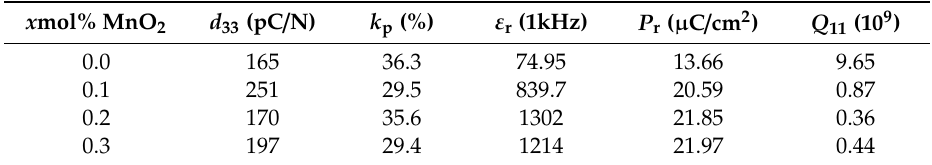
Table 3. Piezoelectric constant d 33 , planar electromechanical coupling factor k p , dielectric constant ε r , remnant polarization P r and electrostriction coefficient Q 11 for KNLNT ceramics at different MnO 2 concentration.